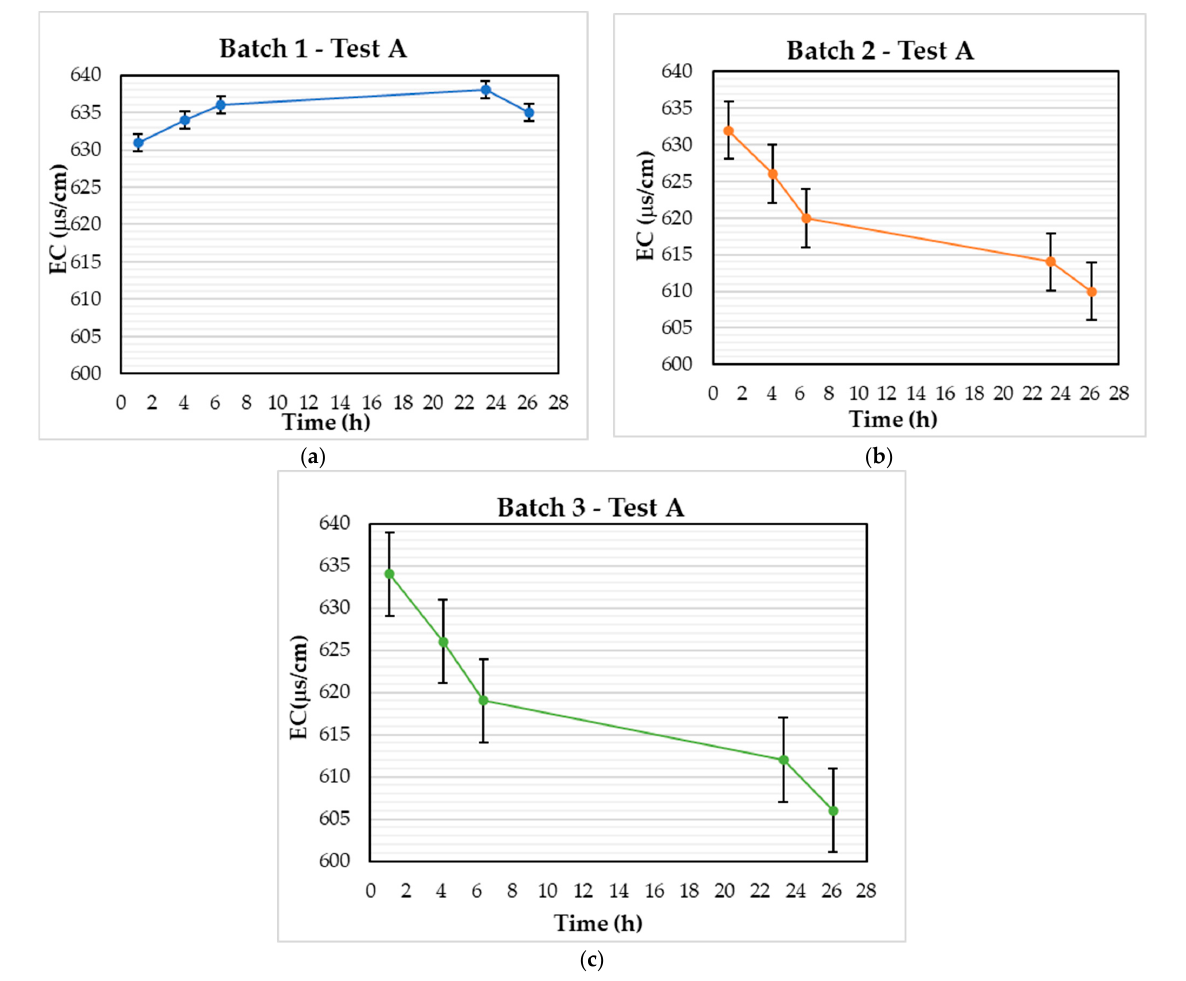
Figure 3. Electrical conductivity trend (Test A): ( a ) Batch 1, ( b ) Batch 2 and ( c ) Batch 3 .